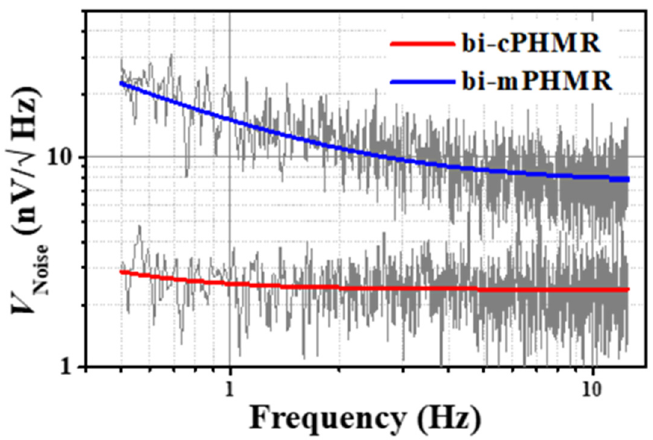
Figure 7. Measured voltage noise for bi-cPHMR and bi-mPHMR sensors at room temperature. Solid line depicts the fit employing the (cid:3495)𝑎 (cid:2868)(cid:2870) + (cid:4672) (cid:3028) (cid:3117) The 1/f noise is presented in measured total average noise <15 Hz.